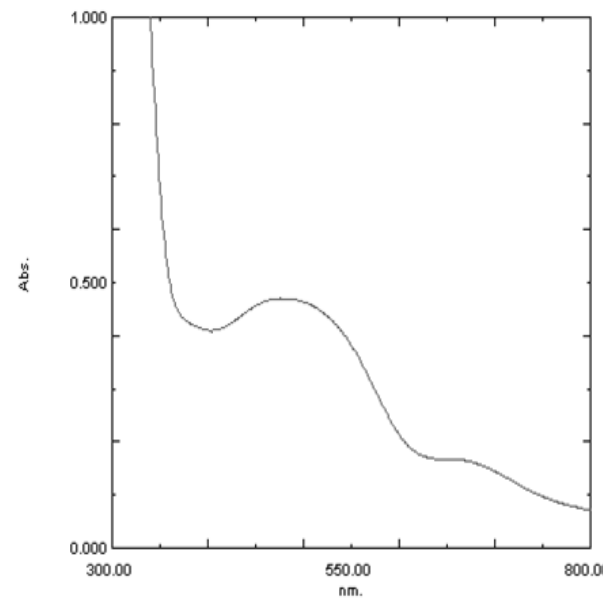
Figure 4. UV-Vis spectrum of Na